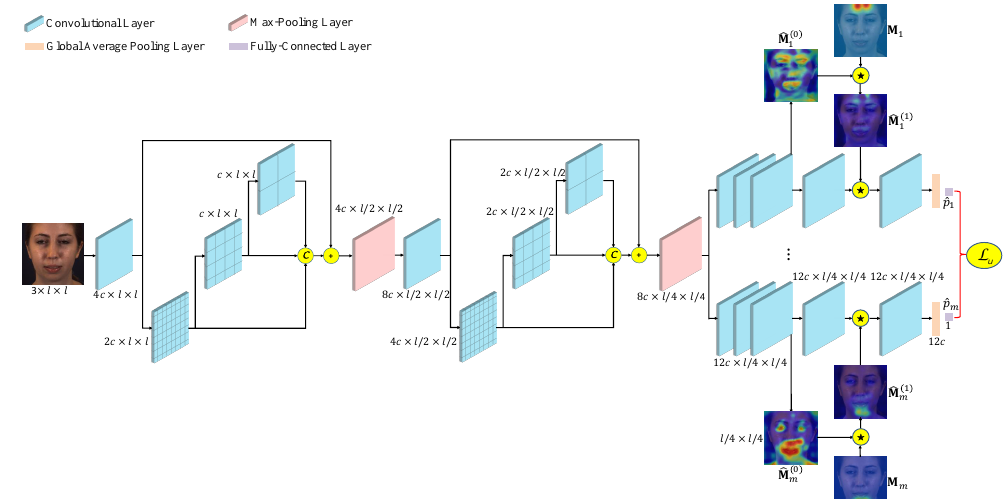
( 0 ) is i ( 1 ) for the i